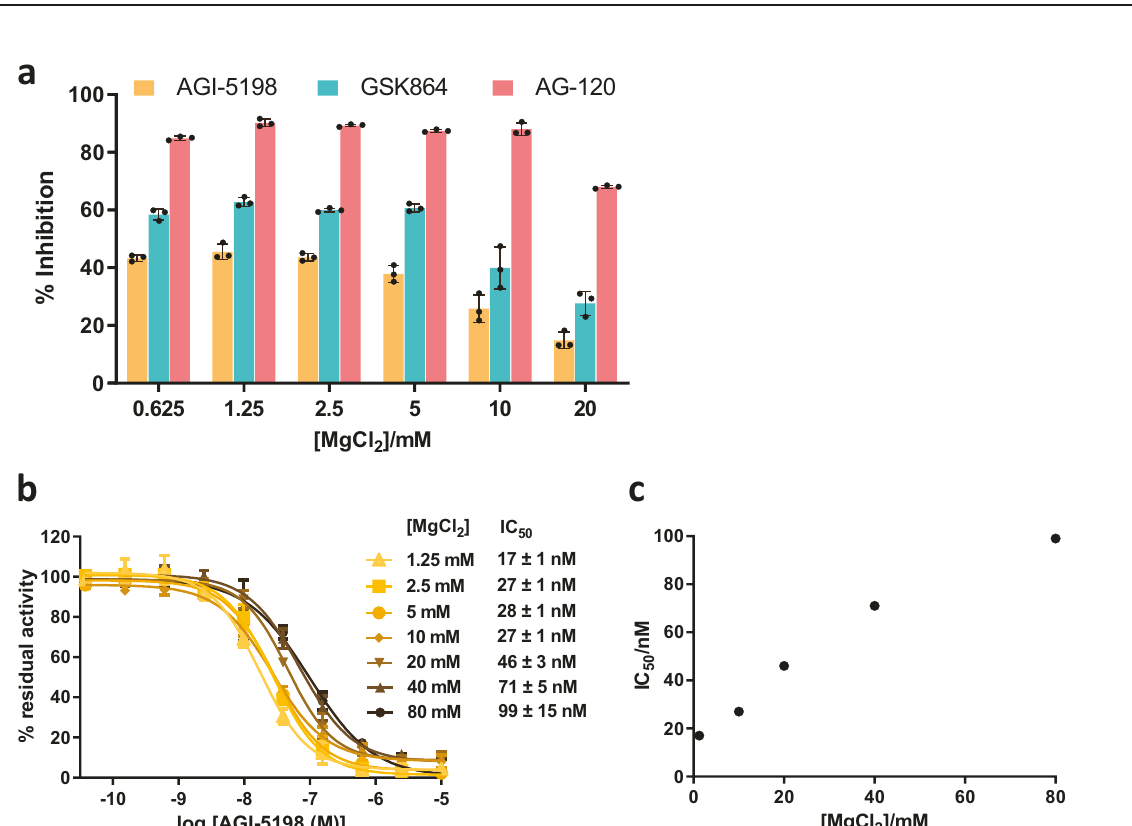
Fig. 5 R132H IDH1 inhibitors do not ef fi ciently displace isocitrate from wt IDH1 in the presence of metal ions, but displace 2OG from R132H IDH1. CPMG-edited 1 H NMR binding analyses of D -isocitrate binding to wt IDH1, or 2OG binding to R132H IDH1, in the presence of inhibitors. Buffer: 50 mM Tris- D 11 -HCl, pH 7.5 in 90% H 2 O/10% D 2 O (v/v). See ‘ Methods ’ for details. a D -isocitrate binding to EDTA-treated wt IDH1 ( D -isocitrate:wt IDH1, 8:1) in the presence of AG-120, without metal ions. b , as a , but with GSK864. D -Isocitrate is partially displaced from wt IDH1 by AG-120 and GSK864 without metal ions. c , d , as a , b , but with 10 mM MgCl 2 . e , f , as a , b , but with 10 mM CaCl 2 . D -Isocitrate is displaced from wt IDH1 by the inhibitors without metal ions, but not in the presence of MgCl 2 or CaCl 2 . g 2OG binding to EDTA-treated R132H IDH1 (2OG:R132H IDH1, 1:1) in the presence of 10 mM CaCl 2 and AG-120. h , as g , but with GSK864. i , j , as g , h , but replacing 2OG and CaCl 2 with NOG and MgCl 2 . 2OG or its surrogate NOG is displaced from R132H IDH1 by the inhibitors in the presence of metal ions. Blue: substrate or substrate – metal complex. Yellow-orange: substrate or substrate – metal complex with IDH1. Orange: substrate or substrate – metal complex with IDH1 and inhibitor.